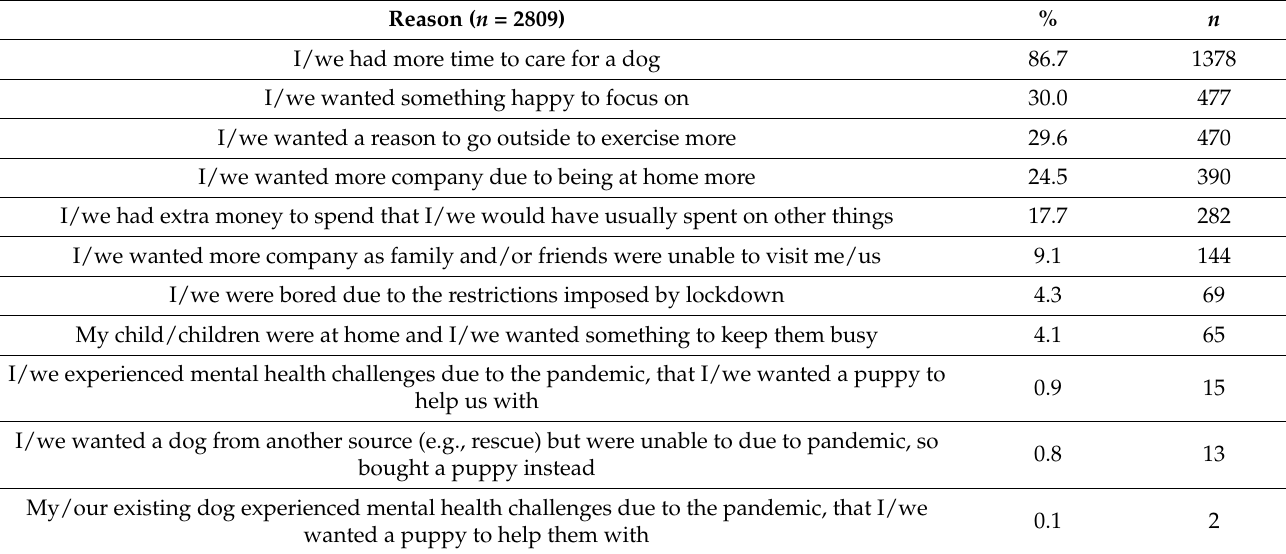
Table 16. Reasons why the COVID-19 pandemic influenced decisions to purchase a puppy ( n = 2809) in the UK during